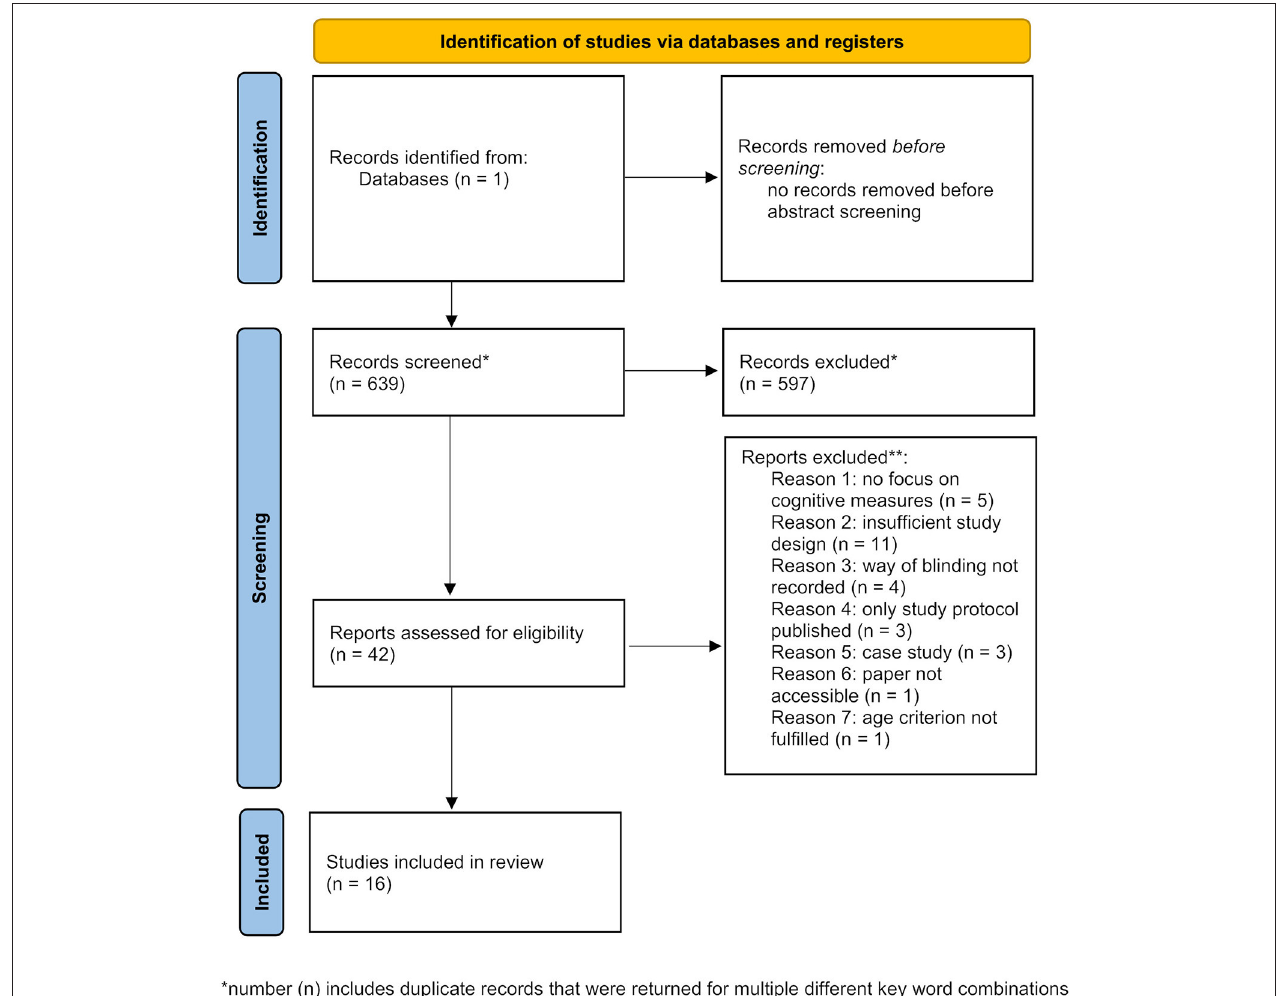
FIGURE 1 | PRISMA flow diagram depicting identification, screening, and inclusion strategies for the selection of the reviewed studies [modified from Page et al. (2021)